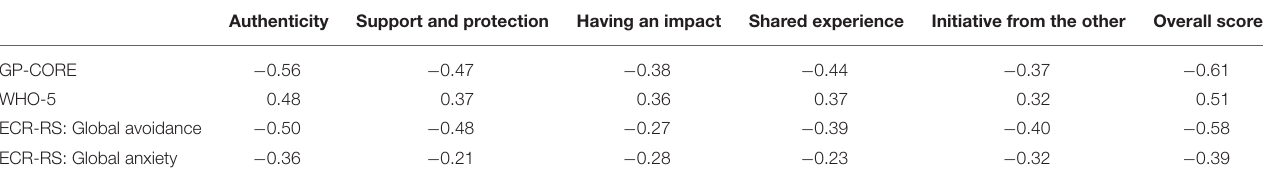
TABLE 5 | Convergent validity of RNSS. Authenticity Support and protection Having an impact Shared experience Initiative from the other Overall score GP-CORE − 0.56 WHO-5 0.48 ECR-RS: Global